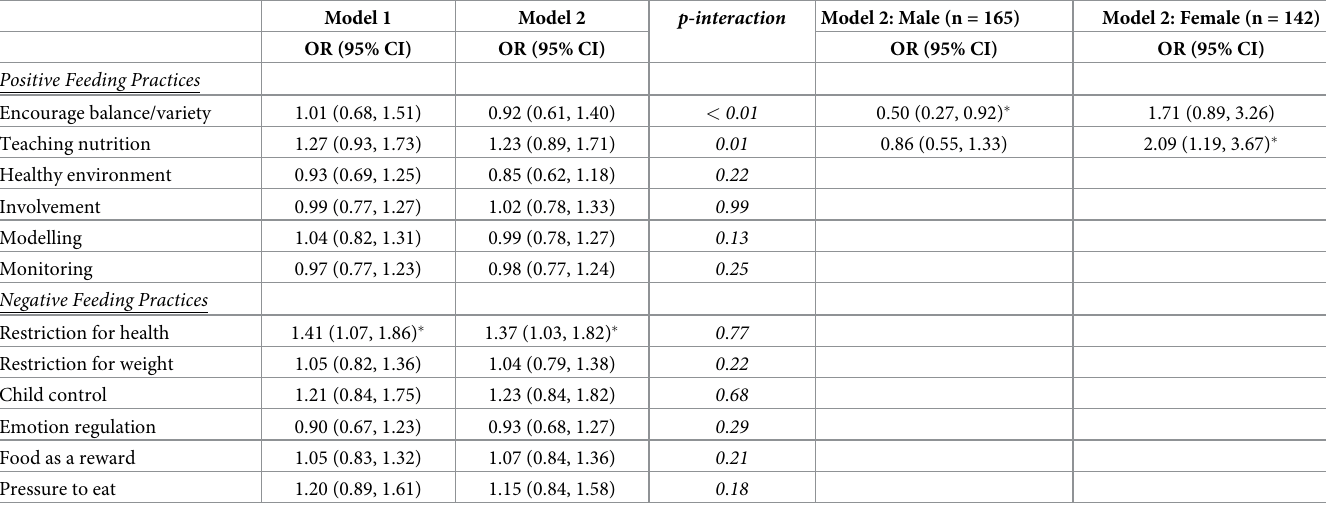
Table 5. Associations between maternal feeding practices at 5 years old and food reward at 6 years old (n =